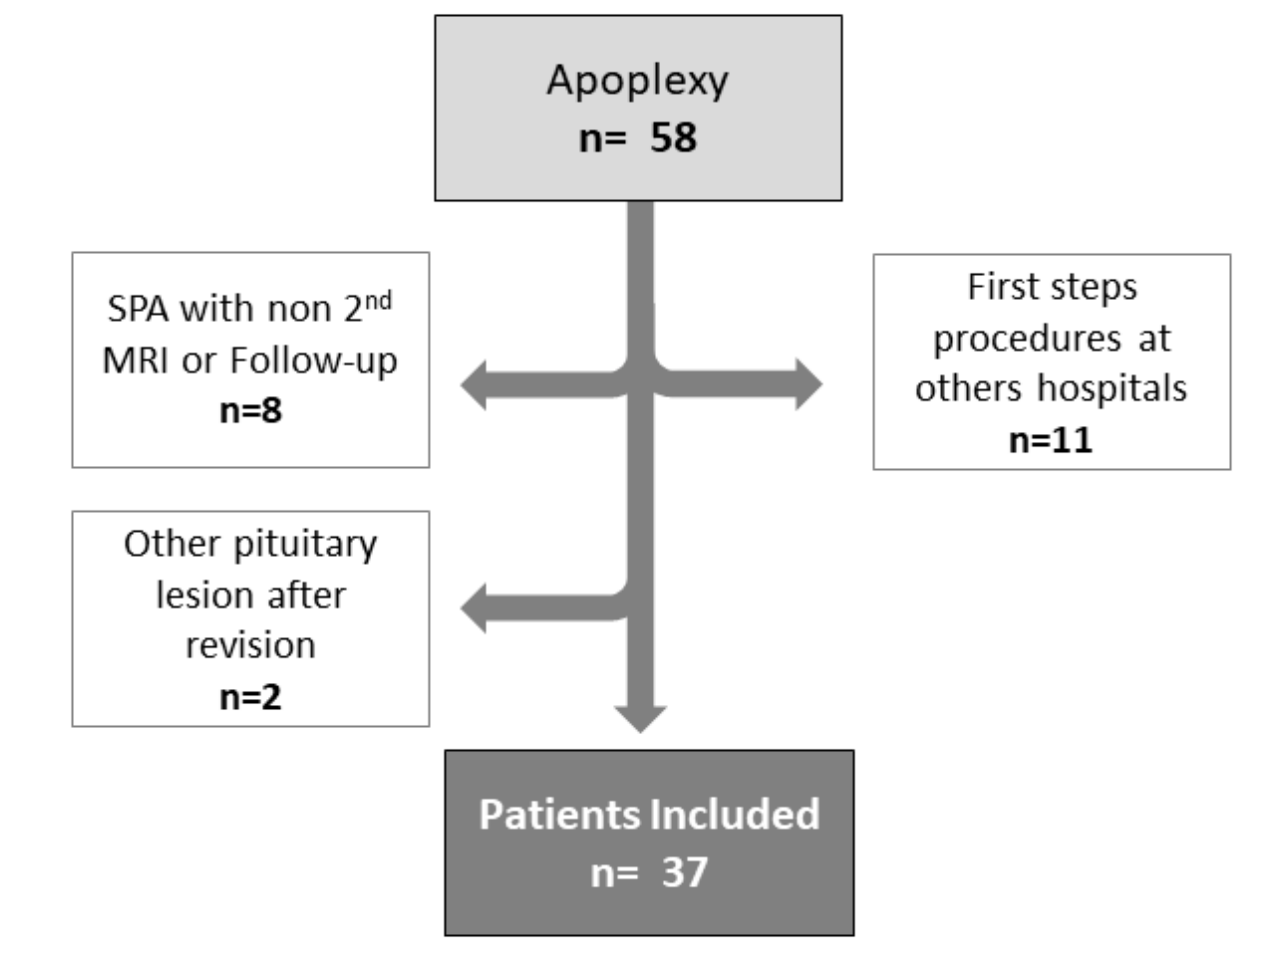
Figure 2. Flow chart of the study. Table 1. Baseline demographic, clinical history, and risk factors of the different types of pitu- itary